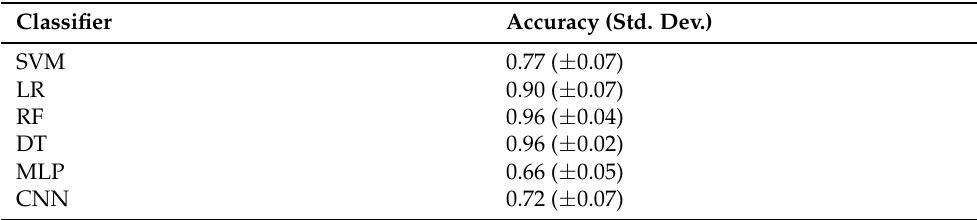
Table 9. Results for both machine and deep learning models using k-flod